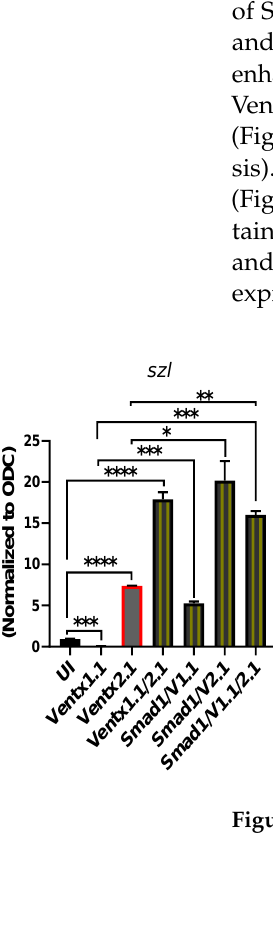
Figure 5. Smad1 enhances Ventx2.1-mediated szl activation and rescues Ventx1.1 mediated szl sup- pression. ( a ) Embryos were injected with smad1 , ventx1.1 and ventx2.1 mRNAs individually and in different combinations. Animal cap explants (10 AC/sample) were dissected at stage eight and quan- titative RT-PCR of ventral specific marker genes including szl at gastrula stage were analyzed. V1.1 = Ventx1.1, V2.1 = Ventx2.1 ( b ) Szl(-1566) promoter construct were injected with smad1 , ventx1.1 and ventx2.1 mRNA alone and possible combinations and reporter gene activities were analyzed. ( c ) Xenopus leavis embryos (300 embryos/sample) were injected with ha.smad1 , 3flag.ventx1.1 , myc.ventx2.1 mRNAs alone and their possible combinations (0.5 ng/embryo each) and cultured to the gastrula stage. ChIP-PCR analysis using specific primers for the szl promoter region having the VRE site was performed. The asterisks of different colors indicate the difference of antibodies used ( d )